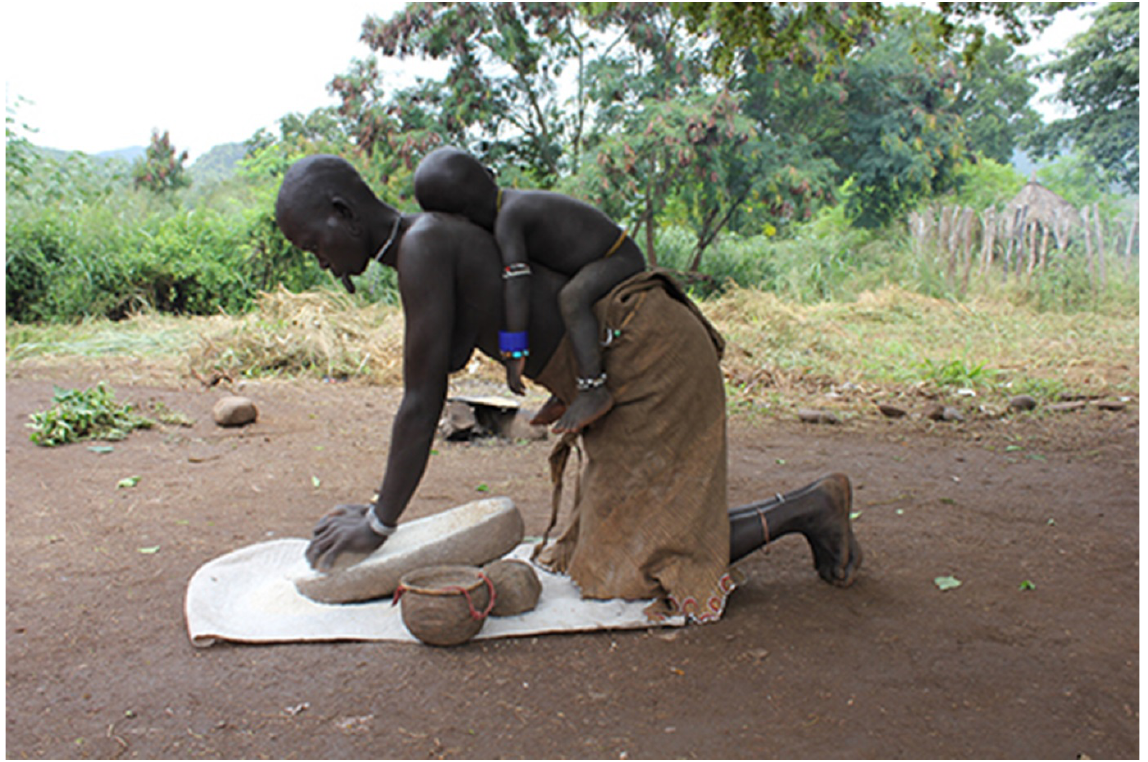
Figure 3. Milling outside of the house. Among the Mursi, the “grinding slab” (golu oiné) means the mother, so the “handstone” (golu joiné) represents the baby. The Mursi say that the handstone must rest well on the grinding slab, just as a baby does on its mother’s back.